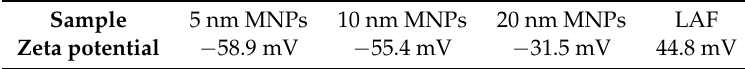
Table 1. Zeta potential of magnetic particles and pure LAF